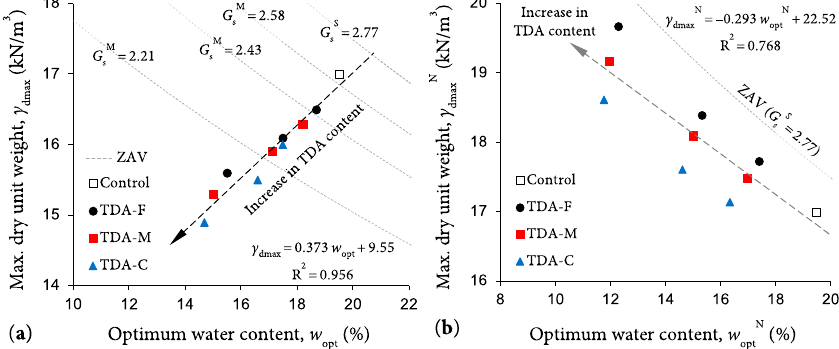
Figure 3. Variations of maximum dry unit weight against optimum water content “path of optimums” for the tested mix designs: ( a ) Conventional definition (i.e., γ dmax – w opt ); and ( b ) Normalized definition (i.e., γ dmaxN – w optN ).